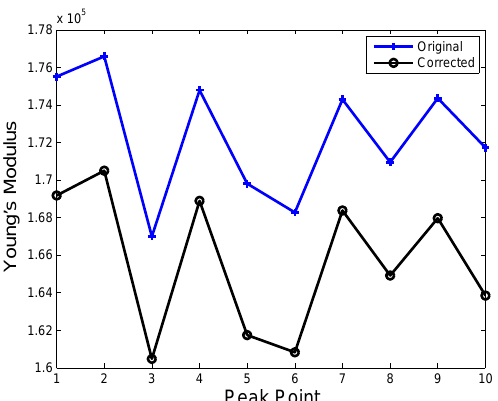
Figure 17. YM for the ’hard inclusion 5 mm beneath the surface.’ The blue curve denotes the YM by original force measured by sensor, and the black curve indicates the YM by compensated force.